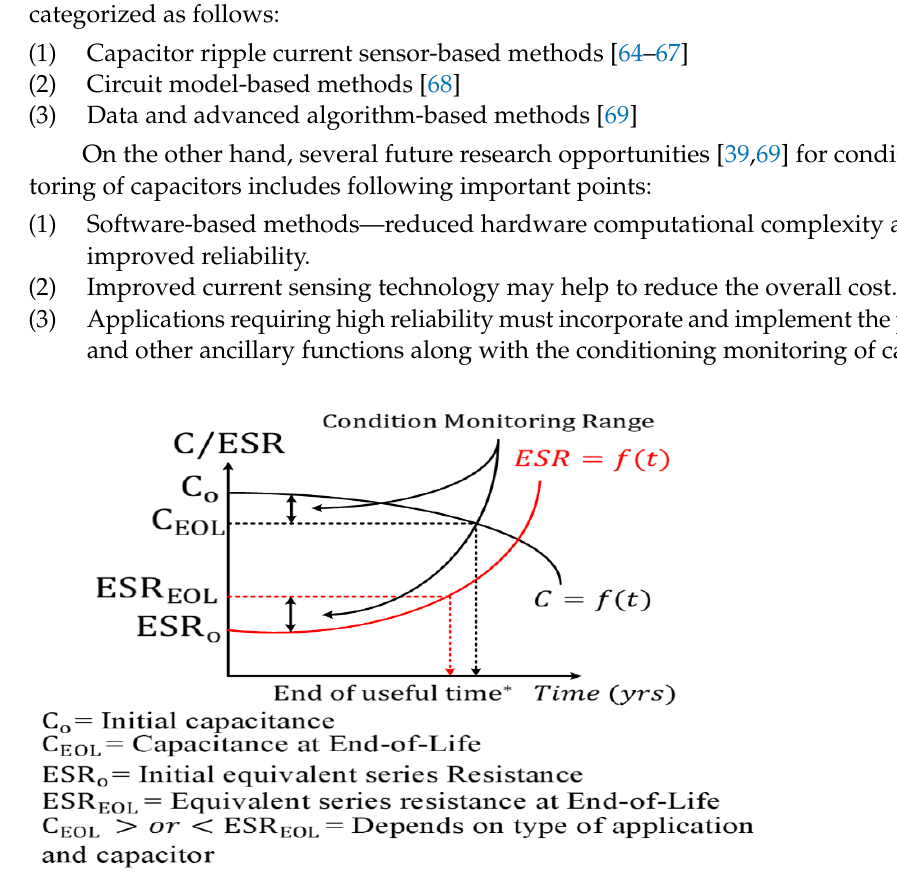
Figure 27. C and ESR curves for capacitor degradation level [70].